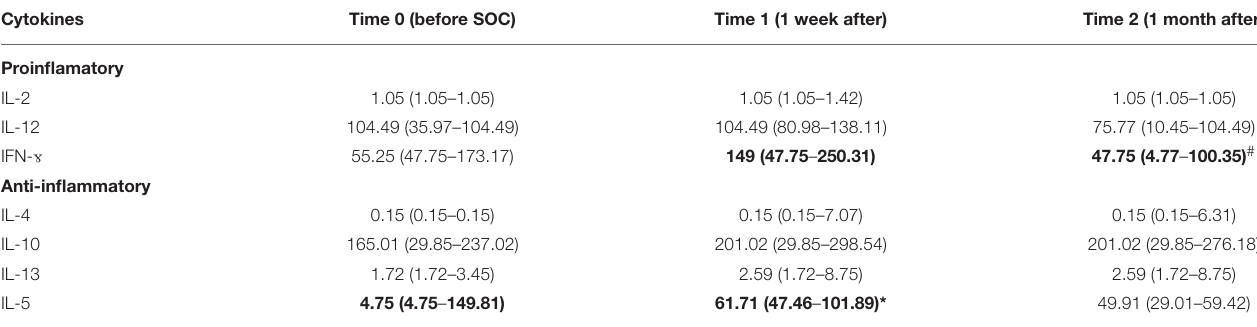
TABLE 4 | Concentration in pg/g of feces (expressed as median and IQR) of immune compounds in fecal samples collected in this study. Cytokines Time 0 (before SOC) Time 1 (1 week after) Time 2 (1 month